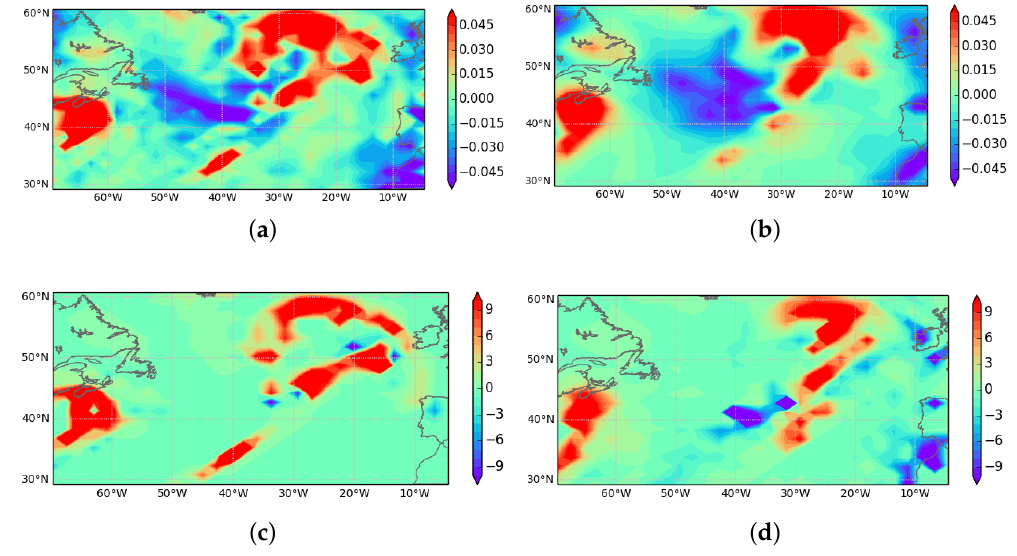
Figure 2. Vertical velocity at 4000m, units ms − 1 : ( a ) directly output from UM; ( b ) calculated from Equation (20) with heating rates at 4000 m, units ◦ K day − 1 ; ( c ) combined heating from precipitation schemes in UM; and ( d ) latent heating deduced as in Section 2.3 (see